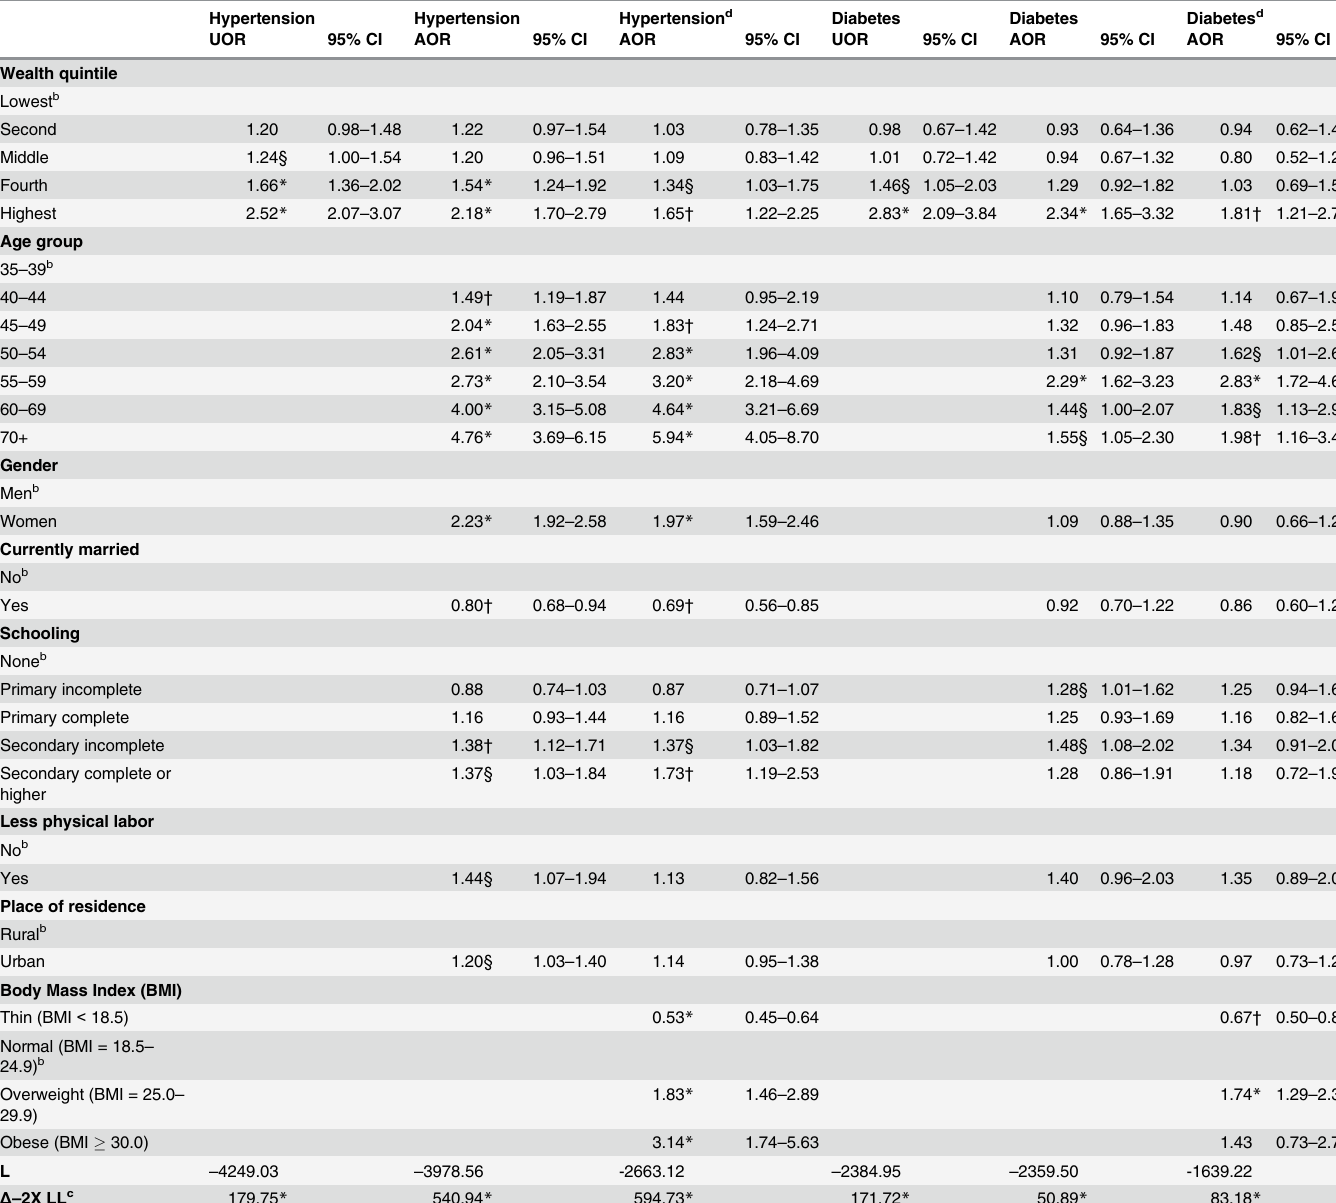
Table 3. Odds ratios of having versus not having morbidity in Bangladesh (N = 7499) a